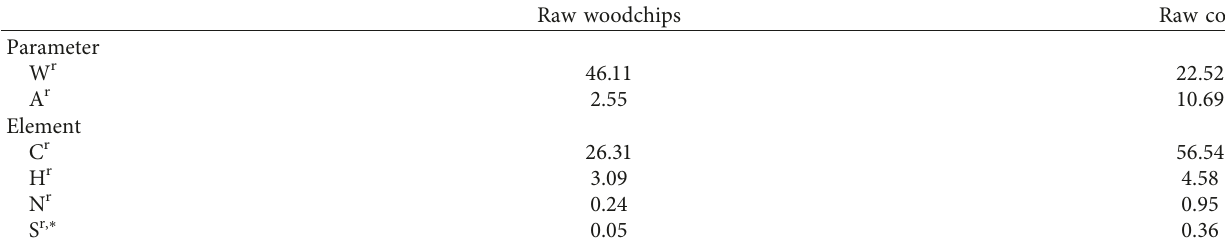
Table 2: Coal and woodchip parameters, wt. %.